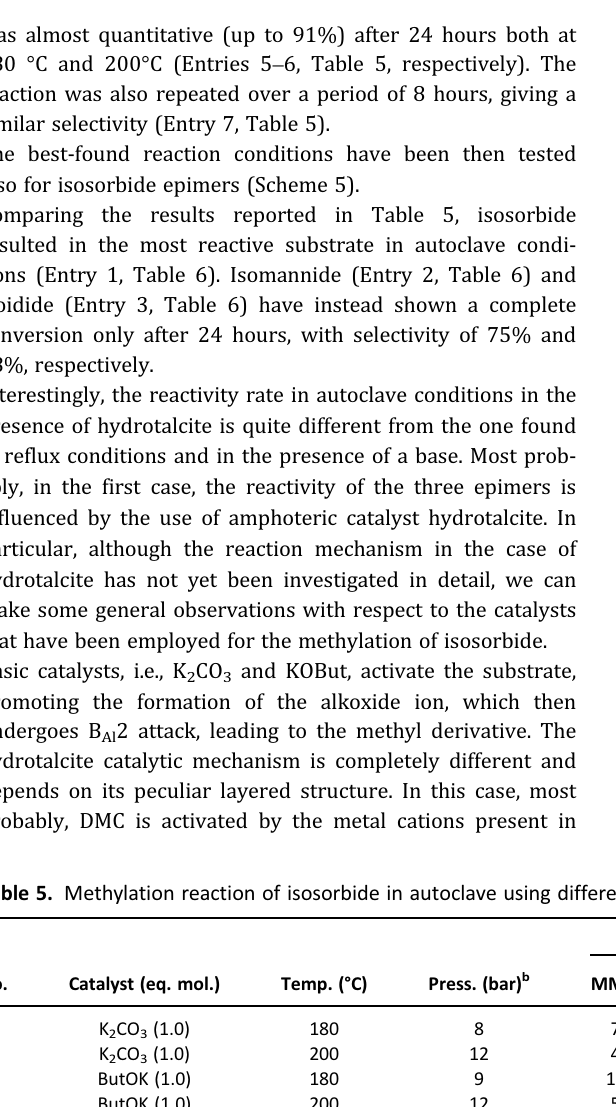
No. Catalyst (eq. mol.)